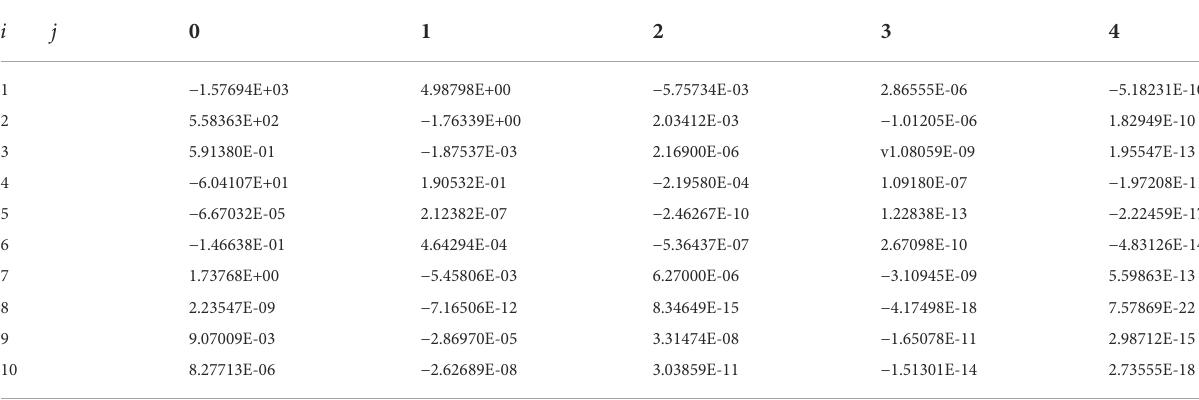
TABLE 4 Value of A η i , j